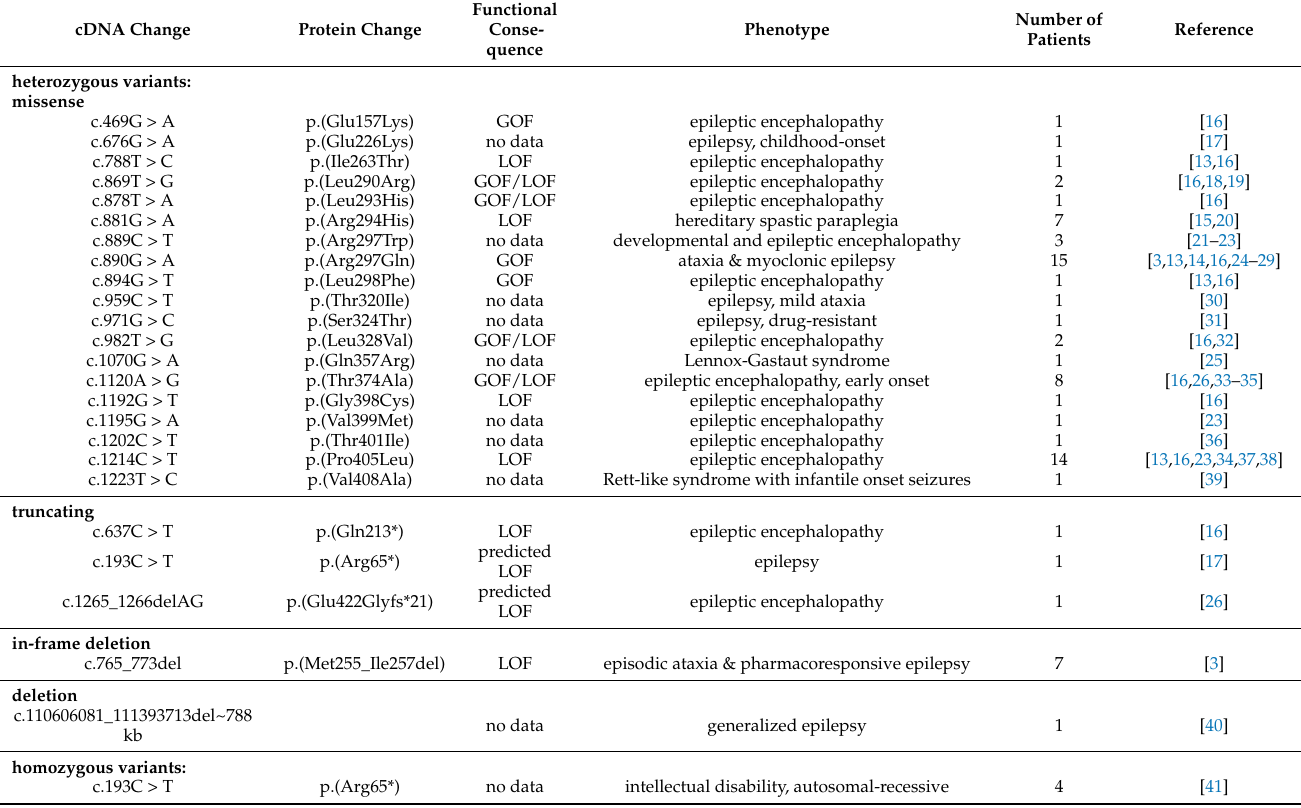
Table 1. KCNA2 variants from published clinical reports.